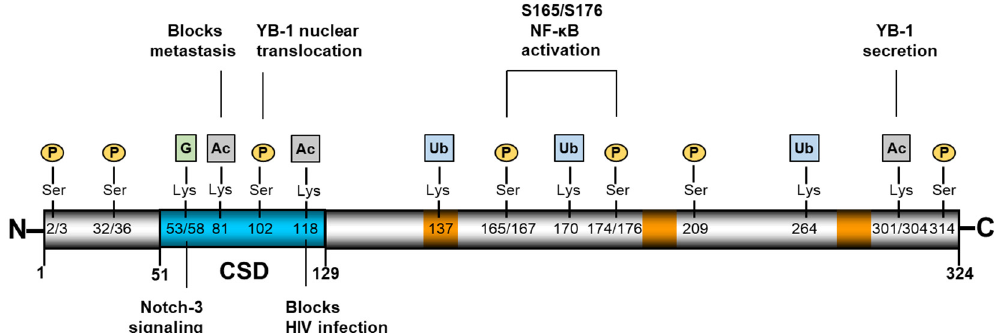
Figure 1. Structural organization of YB-1. YB-1 is a 324 amino-acid protein comprising an alanine/proline-rich N-terminus, a highly conserved nucleic acid binding cold-shock domain (CSD, blue), and a large, disordered C-terminus [5]. YB-1 contains three nuclear localization signals (orange), which comprise stretches of positively charged amino acids. Numerous post-translational modifications have been identified, several of which are shown here along with the known activities. Figure 1 residues, modification types, and corresponding references are shown in Table A1.